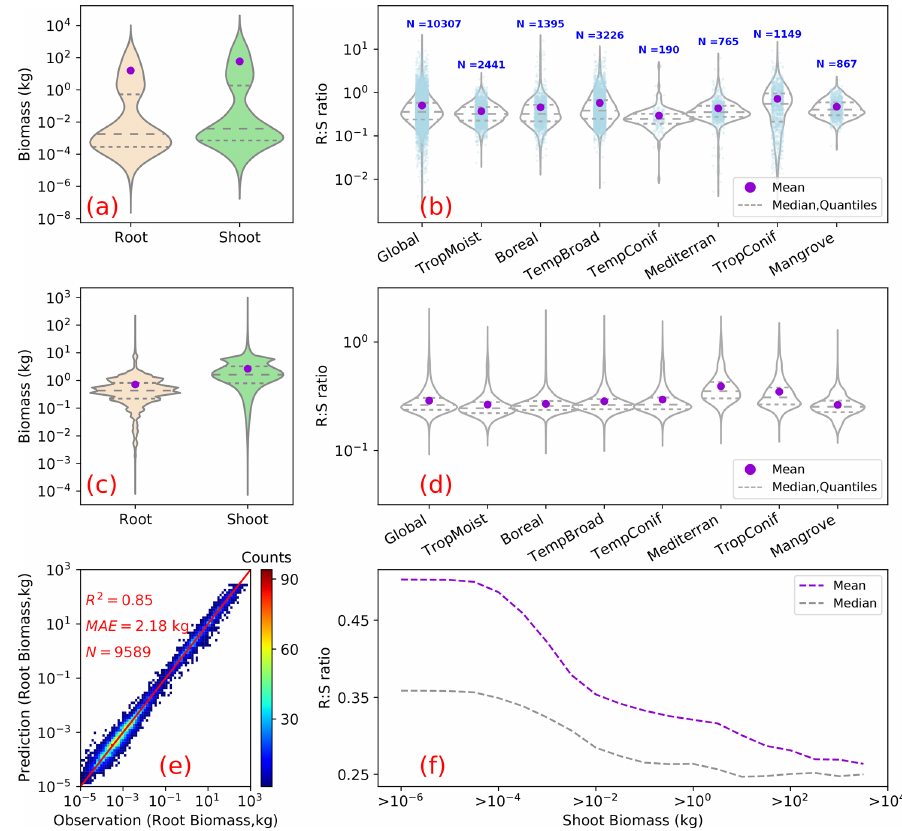
Figure 2. Root biomass and root shoot ratio ( R : S ). Panels (a) and (b) show as violin plots the distribution of root and shoot biomass (in units of kilograms per plant) and R : S ratios in the raw data used for upscaling. Panels (c) and (d) are the distributions of model-predicted root biomass from this study, aboveground biomass used for the prediction, and modeled R : S ratios at the global and biome scales. Panel (e) is a heat plot of observed vs. predicted root biomass in kilograms of root per individual woody plant (see the Supplement, Figs. 7–9, for cross-validation at biome, tree size class and continental scales). Panel (f) shows the mean (purple) and median (grey) R : S as a function of shoot biomass from observations. A shift of the shoot biomass towards a larger size (a, c) results in a smaller predicted mean R : S at the global scale (b, d) (see the Supplement, Table S4, for exact values) as the mean R : S is size dependent. R 2 is the coefficient of determination; MAE is the mean absolute error; and N is the number of samples. TropMoist: tropical moist forest; Boreal: boreal forest/taiga; TempBroad: temperate broadleaf and mixed forest; TempConif: temperate coniferous forest; Mediterran: Mediterranean forests, woodlands and scrub; TropConif: tropical and subtropical coniferous forest; and Mangrove: mangrove forest. Note that the scales of the y axes are different between (a) and (c) and between (b) and (d) . Model training and prediction were conducted on filtered data with R : S falling between the 1st and 99th percentiles and shoot biomass matching the range derived from GlobBiomass AGB (Santoro et al., 2021; Santoro, 2018) to reduce impacts from